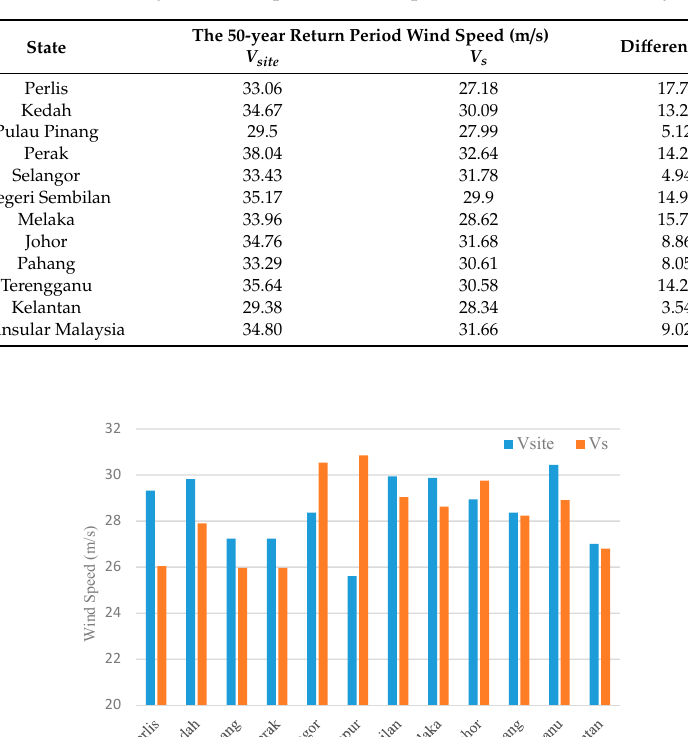
Table 8. The 50-year return period wind speeds of Peninsular Malaysia.